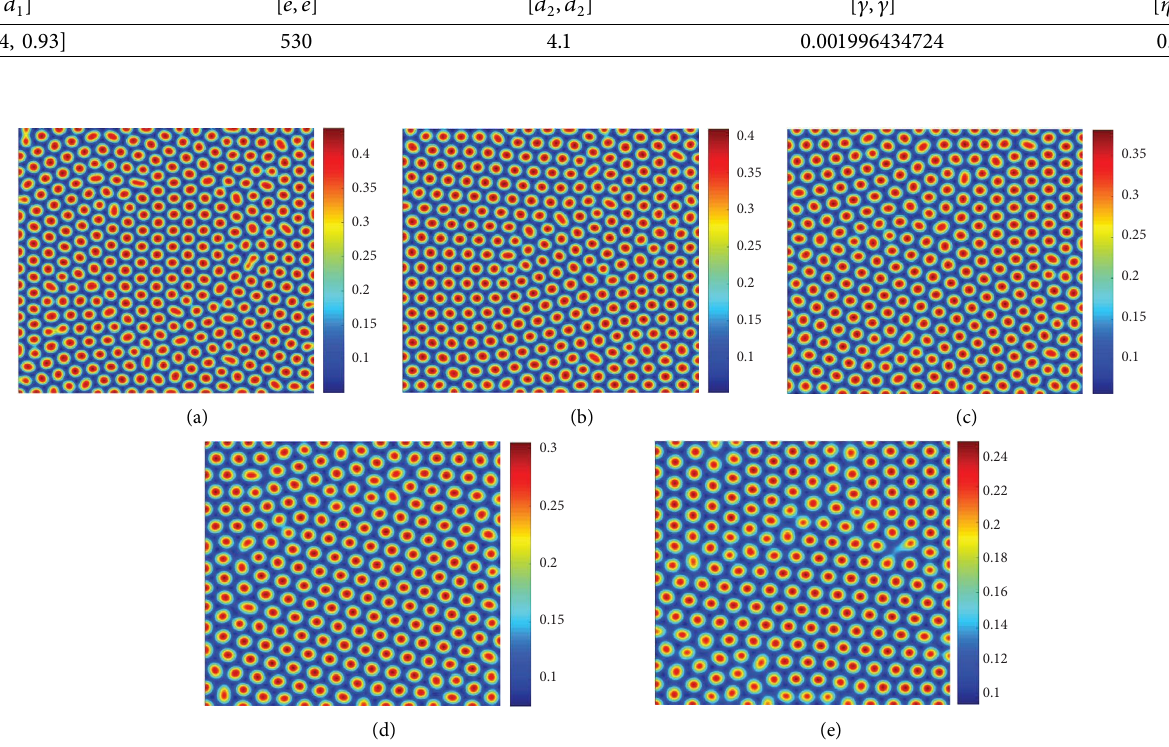
. (a) q � 0, (b) q � 0 . 4, (c) q � 0 . 6, (d) q � 0 . 8, and (e) q � 1